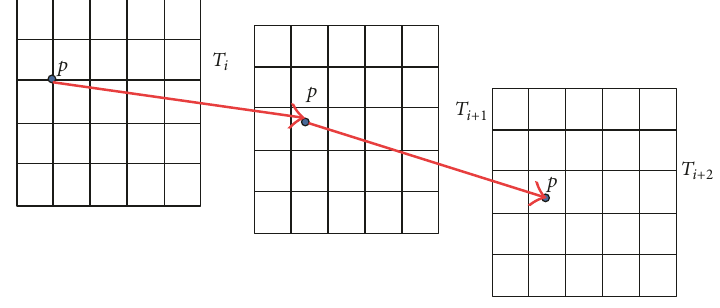
Figure 1: Superposition of deformation